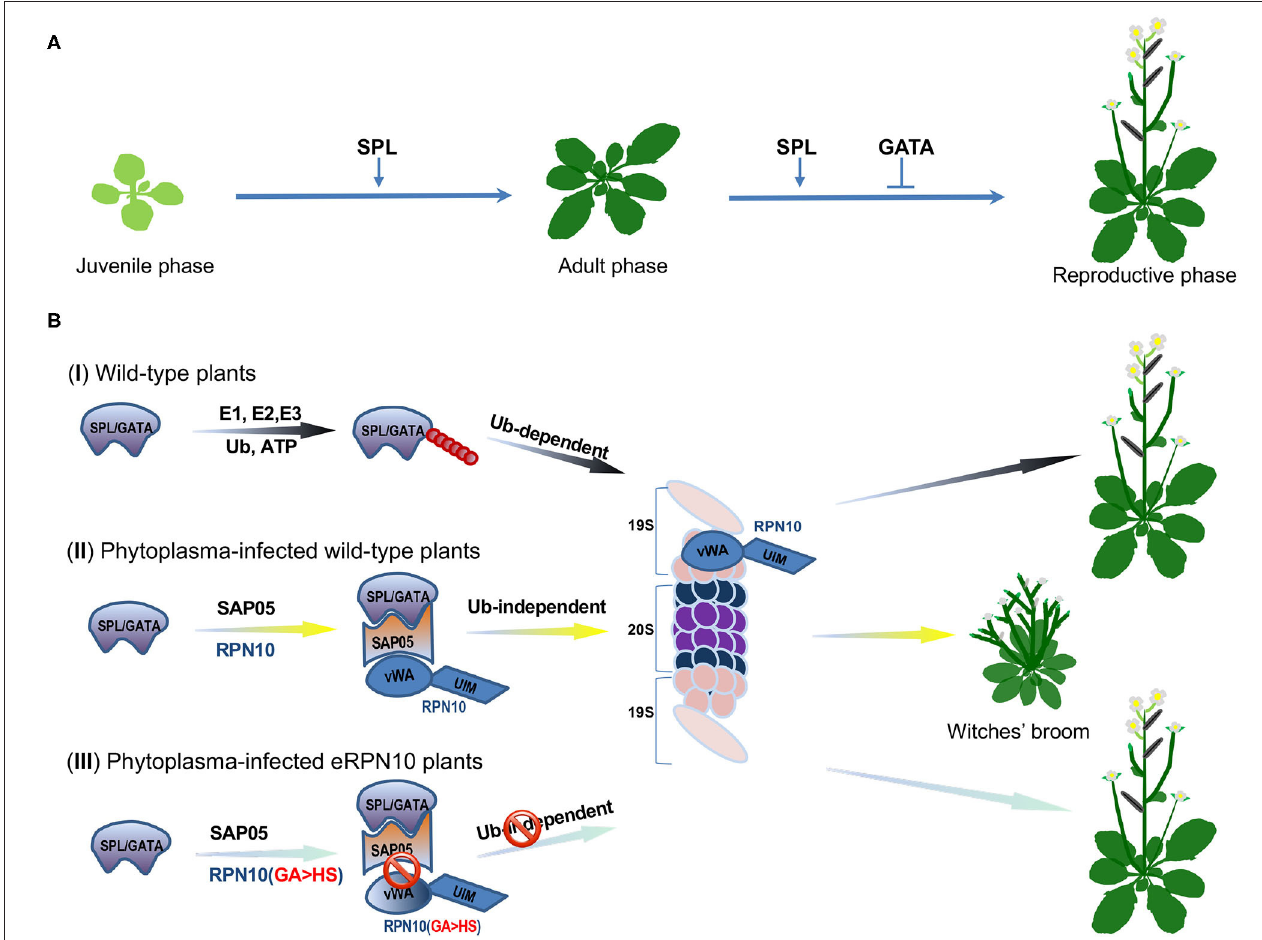
FIGURE 1 | SAP05 modulates host plant developmental processes by hijacking the RPN10 subunit of plant 26S proteasome. (A) A schematic model of Squamosa promoter binding protein-like (SPL) and GATA transcription factors (TFs)-orchestrated wild-type plant growth and development. The SPLs promote the juvenile-to-adult and adult-to-reproductive phase transition, whereas GATA proteins suppress floral organ development. (B) Diagrams of SPL/GATA TFs degradation at the plant 26S proteasome. (I) Under normal growth conditions, SPL/GATA TFs are constitutively subjected to ubiquitin-dependent degradation by the ubiquitin-proteasome system (UPS) to meet the demands of plant growth and development. The ubiquitin molecules are depicted as filled red circles. (II) In phytoplasma-infected plants, the effector SAP05 forms a bridge between host ubiquitin receptor RPN10 and SPLs/GATAs to mediate ubiquitin-independent degradation of these TFs at the 26S proteasome. The degradation of SPL and GATA proteins leads to the decoupling of developmental phase transitions and, thus, keeps the host plant stay at the juvenile stage with more lateral shoots, secondary branches, and sterile flowers. (III) The SAP05 fails to bind the engineered plant RPN10 with two amino acids (38GA39) being replaced with HS (eRPN10 or RPN10 m1). The disassociation of SAP05 and eRPN10 abolishes the ubiquitin-independent degradation of SPL/GATA TFs, conferring the eRPN10-expressing plant’s resistance to SAP05 activities, thus, maintaining wild-type architecture. The SPL/GATA proteins are represented as a light purple irregular shape, the SAP05 is delineated in orange, the RPN10 and eRPN10 are rendered in blue, the subunits of the 19S regulatory particle of the 26S proteasome are depicted in light salmon, whereas the α and β subunits that constitute the 20S proteasome complex are in dark blue and purple,